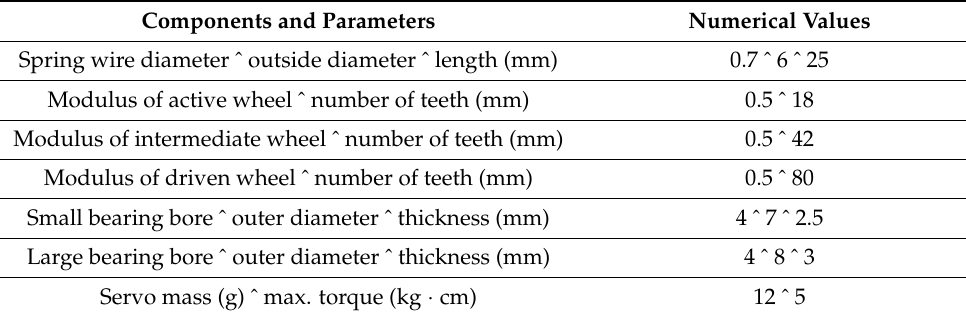
Table 2. Relevant component type